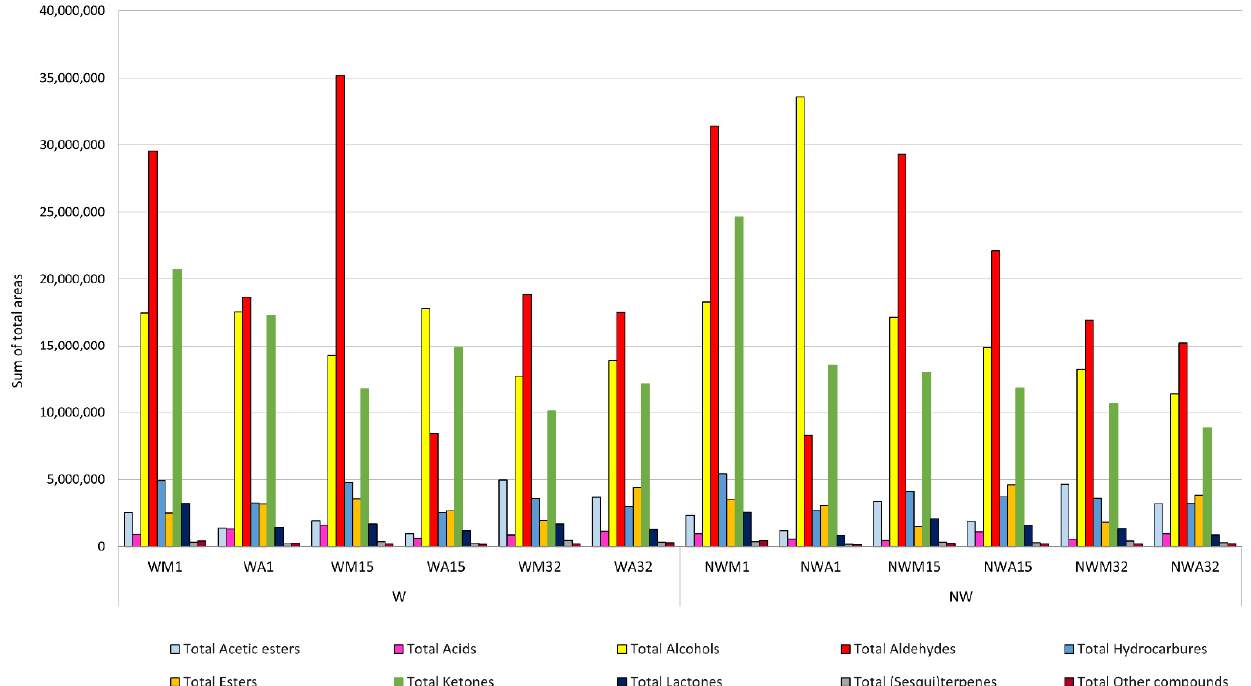
Figure 3. Areas of the different chemical families of volatile compounds determined in the different Organic Extra Virgin Olive Oil (OEVOOs) analyzed according to the washing (W) or non-washing (NW) process, the time of collection (Morning-M or Afternoon-A), and maturation stage (I–III). Stage I (collection day 1), stage II (collection day 15), stage III (collection day 32). To better study the differences in the volatile profile due to the washing and non-